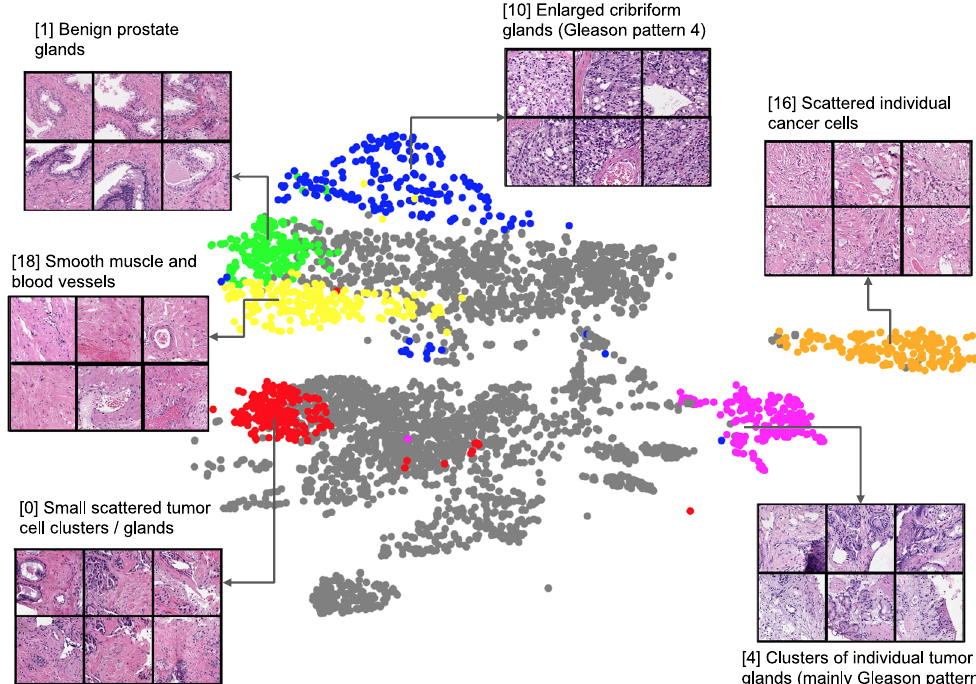
Fig. 2 Pathologist interpretation of self-supervised model tissue clusters. The self-supervised model in the multimodal model was trained to identify whether or not augmented versions of small patches of tissue came from the same original patch, without ever seeing clinical data labels. After training, each image patch in the dataset of 10.05 M image patches was fed through this model to extract a 128-dimensional feature vector, and the UMAP algorithm 27 was used to cluster and visualize the resultant vectors. A pathologist was then asked to interpret the 20 image patches closest to each of the 25 cluster centroids — the descriptions are shown next to the insets. For clarity, we only highlight 6 clusters (colored), and show the remaining clusters in gray. See Supplementary Fig. 2 for full pathologist annotation.